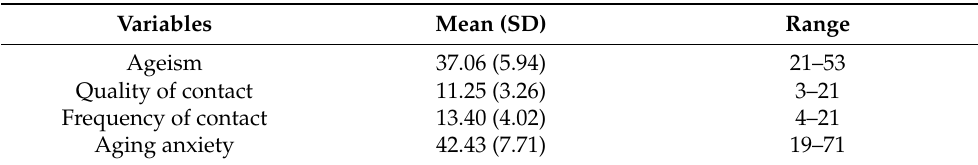
Table 2. Descriptive statistics for ageism, quality and frequency of contact experience, and aging anxiety ( N =